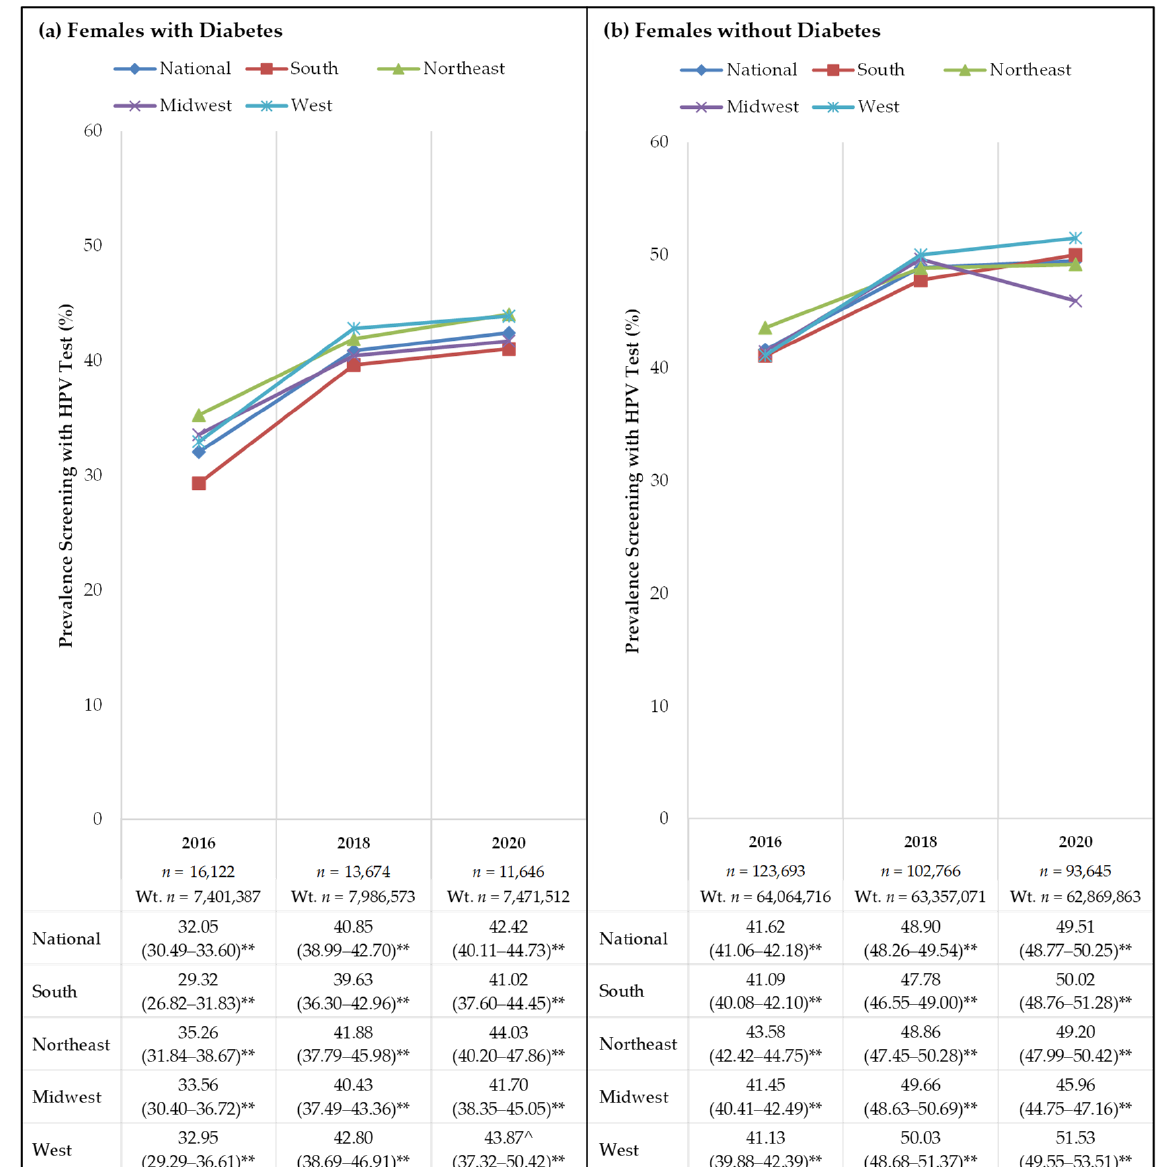
Figure 1. ( a ) HPV Testing Behaviors among Females with Diabetes across Geographic Areas of the U.S.; ( b ) HPV Testing Behaviors among Females without Diabetes across Geographic Areas of the U.S. Weighted percentages (Weighted % (95% CI)) are presented for females who self-reported screening for cervical cancer with HPV test; age parameters follow the American Cancer Society’s guidelines for screening. Wt. n = weighted sample size. ˆ Use caution when interpreting this sub-group prevalence estimate; 95% confidence interval width > 10. ** p < 0.05; chi-square tests detected significant differences in prevalence screening with HPV test between females with and without diabetes.